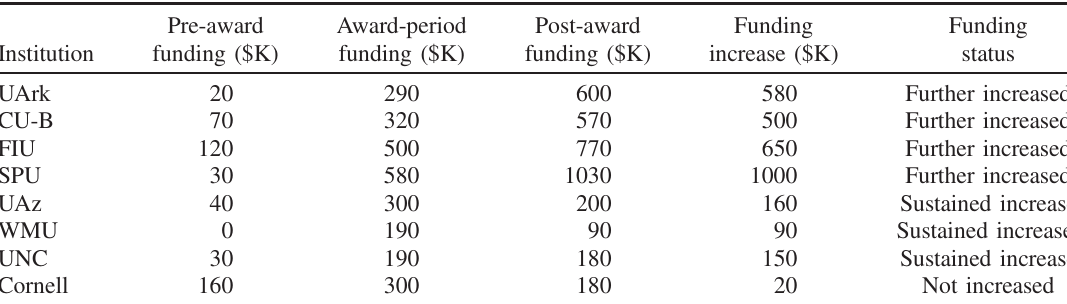
TABLE II. PhysTEC legacy sites ’ funding for physics teacher preparation over the long term. “ Funding increase